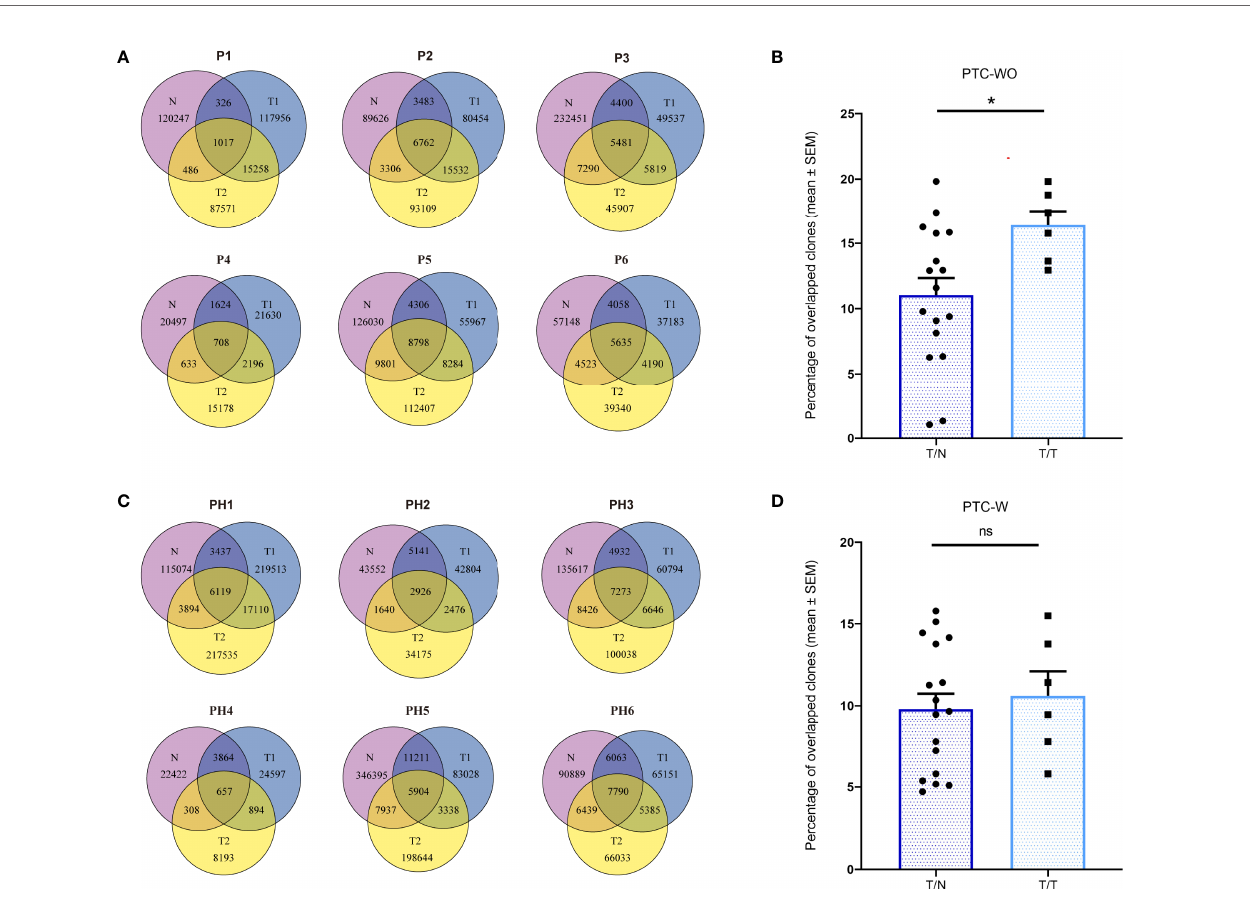
FIGURE 3 | The overlapping proportions of TCR clones across different samples in PTC with and without HT. (A) The overlapping proportions of TCR clones among different samples in PTC without HT. (B) The overlapping proportions of TCR clones between tumor (T) and normal (N) samples as well as between different tumor samples in each PTC without HT. (C) The overlapping proportions of TCR clones among different samples in PTC with HT. (D) The overlapping proportions of TCR clones between tumor (T) and normal (N) samples as well as between different tumor samples in each PTC with HT. *P < 0.05; ns, not signi fi